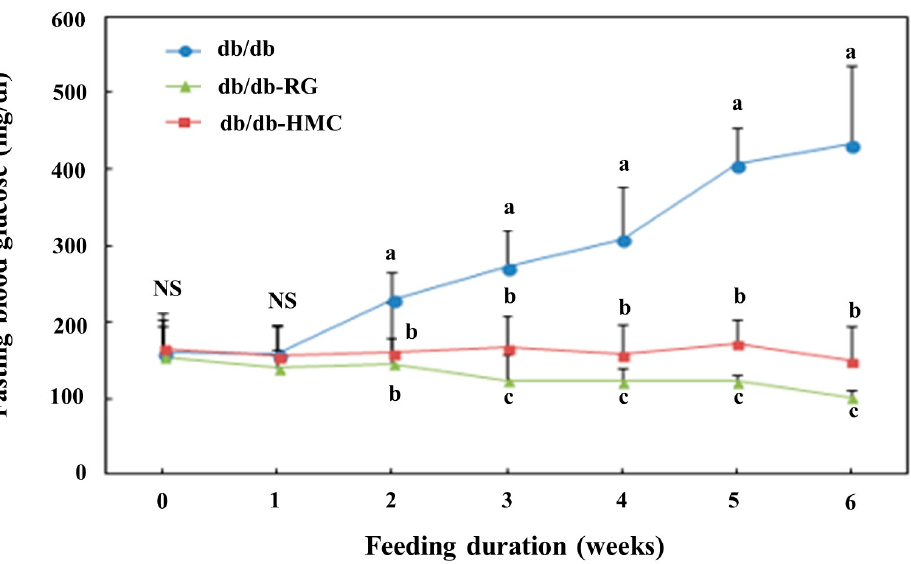
Figure 2. Effects of HM-chromanone administration on fasting blood glucose. Mean ± SD ( n = 8). a–c The mean values that are not indicated by a common letter are significantly different among the groups ( p < 0.05) according to Duncan’s multiple range test. NS, not significant; SD, standard deviation. db/db, db/db-RG (5 mg/kg BW per day) and db/db-HMC group (30 mg/kg BW per day).